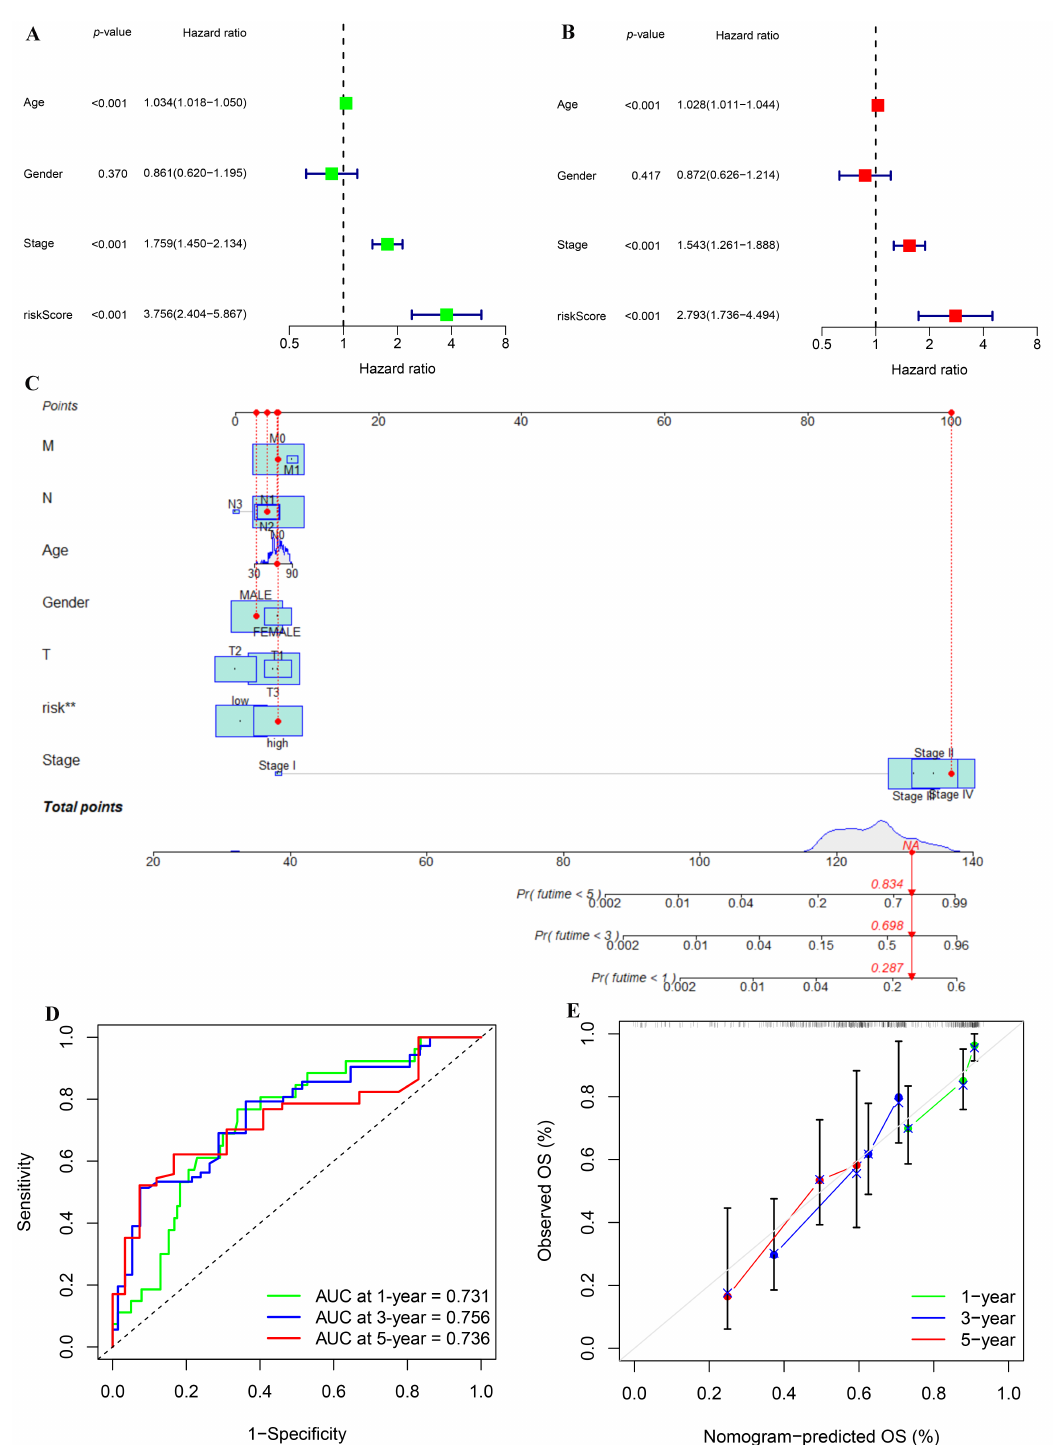
Figure 7. Univariate and multivariate Cox regression analyses and construction and analysis of a nomogram. ( A ) Forest plot of univariate Cox regression analysis in the TCGA-BLCA